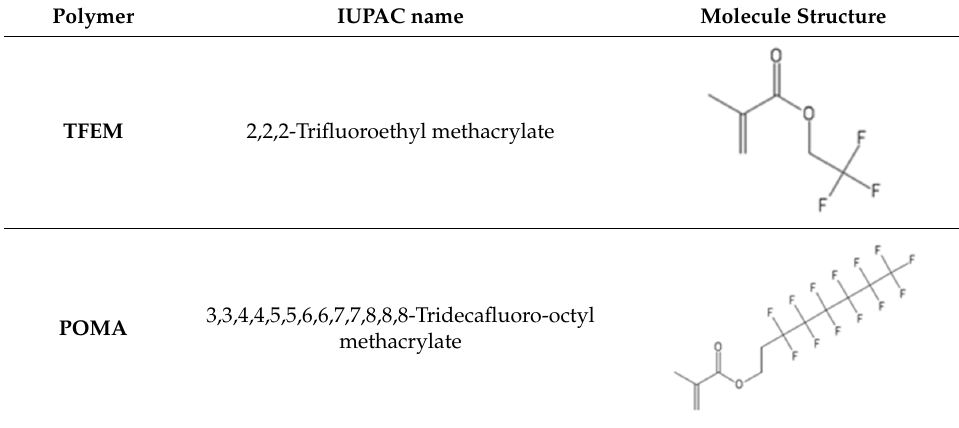
Figure 9. Important properties for engineering nanoparticles (NP) for photo-catalytic